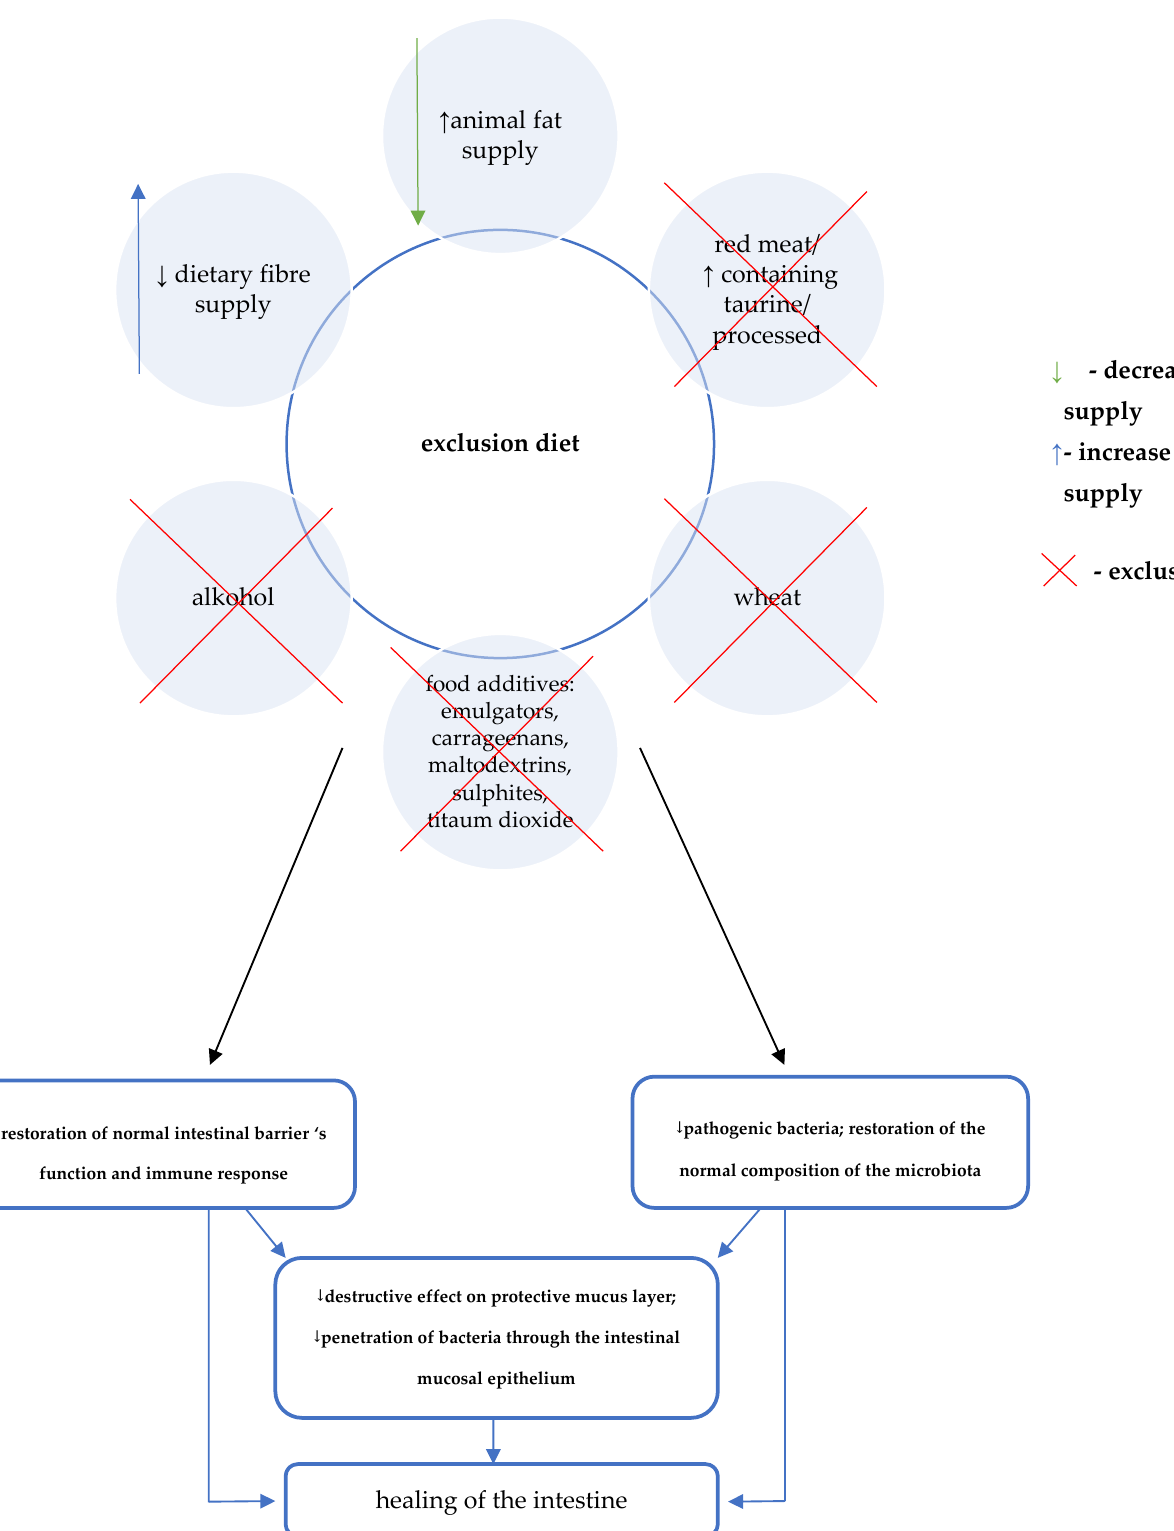
Figure 3. CDED diet and the treatment of Crohn's disease [7,31-32]. Figure 3. Crohn’s Disease Exclusion Diet (CDED) diet and the treatment of Crohn’s disease